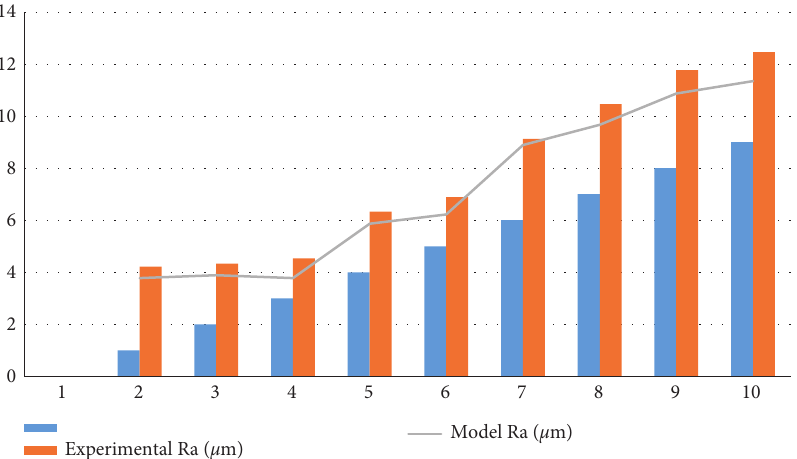
Figure 6: Comparison of Ra values of the simulation and experiment.